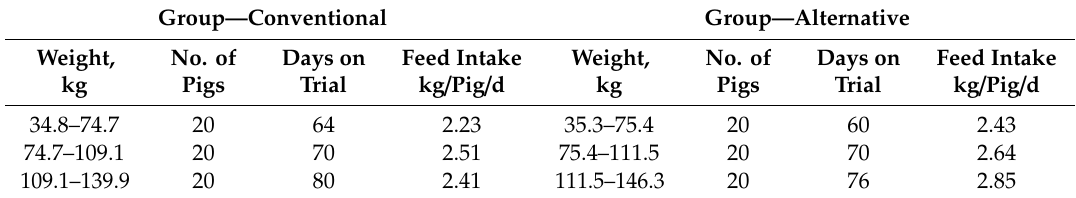
Table A2. Data on Basque breed used for modelling [11] 1 .